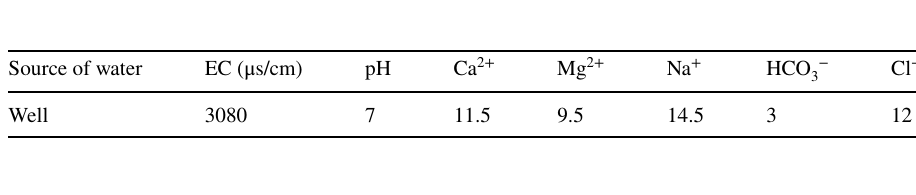
Table 4 Physical and chemical properties of soil samples